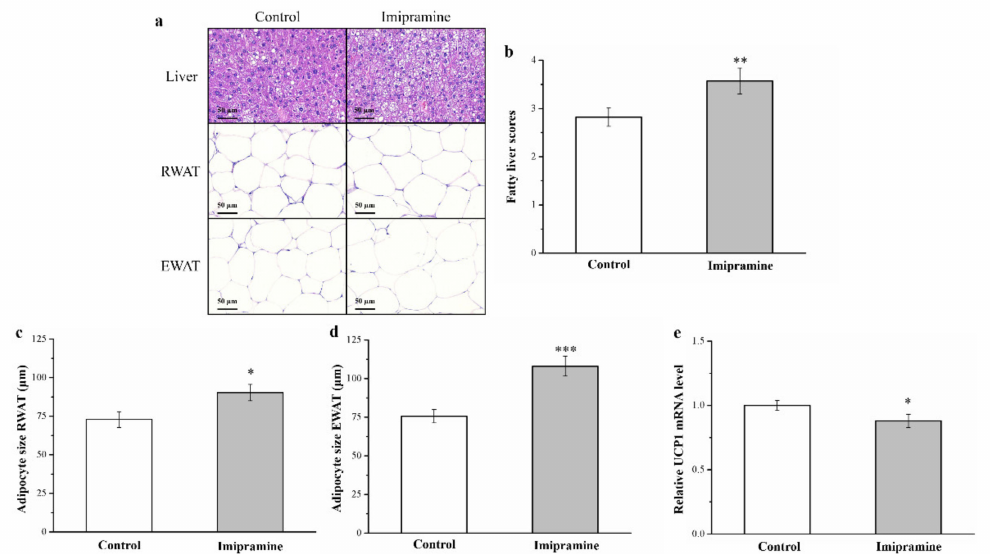
Figure 3. Effects of imipramine on ( a ) the mouse livers, retroperitoneal white adipose tissue (RWAT), and epididymal white adipose tissue (EWAT) of control and treated mice, as determined through hematoxylin and eosin staining (magnification, 200 × ). ( b ) Fatty liver score findings. ( c ) RWAT and ( d ) EWAT adipocyte sizes and ( e ) the mRNA expression of UCP1 in brown adipose tissue were measured in HFD-fed control and imipramine-treated obese mice. Data are in the form of mean ± standard deviation ( n = 8). * p < 0.05; ** p < 0.01; *** p < 0.001. Table 2. Influence of imipramine on fat cell sizes in HFD-fed controls and imipramine-treated mice. Variable Control Imipramine Retroperitoneal white adipose tissue (RWAT) Adipocyte diameter 0–40 µ m (%) 17.59 ± 0.43